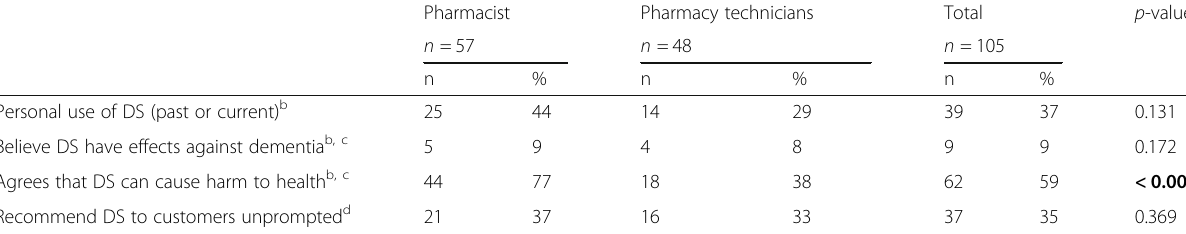
Table 1 Pharmacists ’ and pharmacy technicians ’ attitudes toward dietary supplements Pharmacist